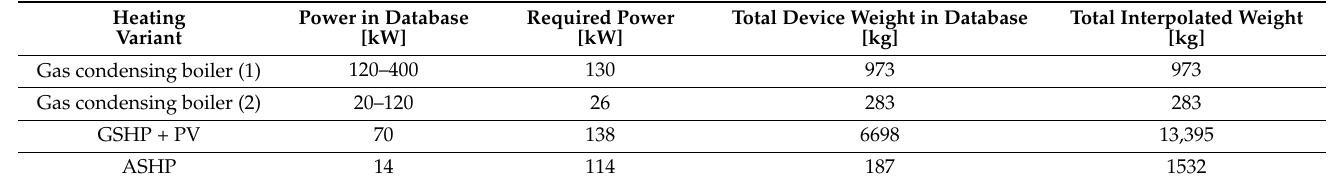
Table 4. Input data for transport from manufacturer to consumer, GSHP: ground-source heat pump, ASHP: air-source heat pump, PV: